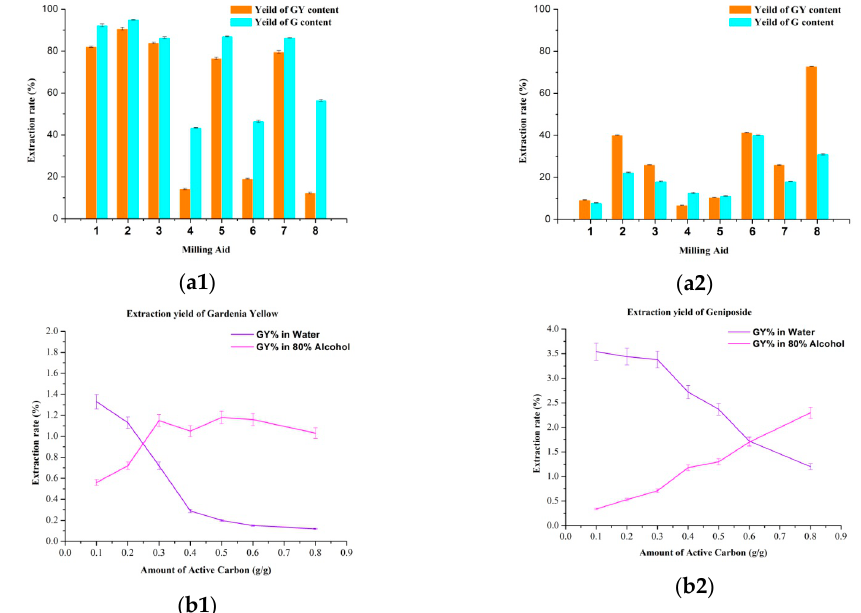
Figure 2. The influence of milling aids (50% wt. milling aid, 400 rpm, powder-to-ball weight ratio 1:5, 5 min) on ( a1 ) Water extraction (liquid-solid ratio 20:1) at 20 °C for 5 min and ( a2 ) 80% of ethanol extraction (liquid-solid ratio 20:1) at 80 °C for 5 min. 1. No additive; 2. silica gel; 3. neutral alumina; 4. zinc carbonate; 5. calcium carbonate; 6. diatomite; 7. polyaluminium chloride; 8. active carbon. The influence of different amout of activated carbon (400 rpm, powder-to-ball weight ratio 1:5, 5 min) in ( b1 )water extraction and ( b2 ) alcohol extraction at the same